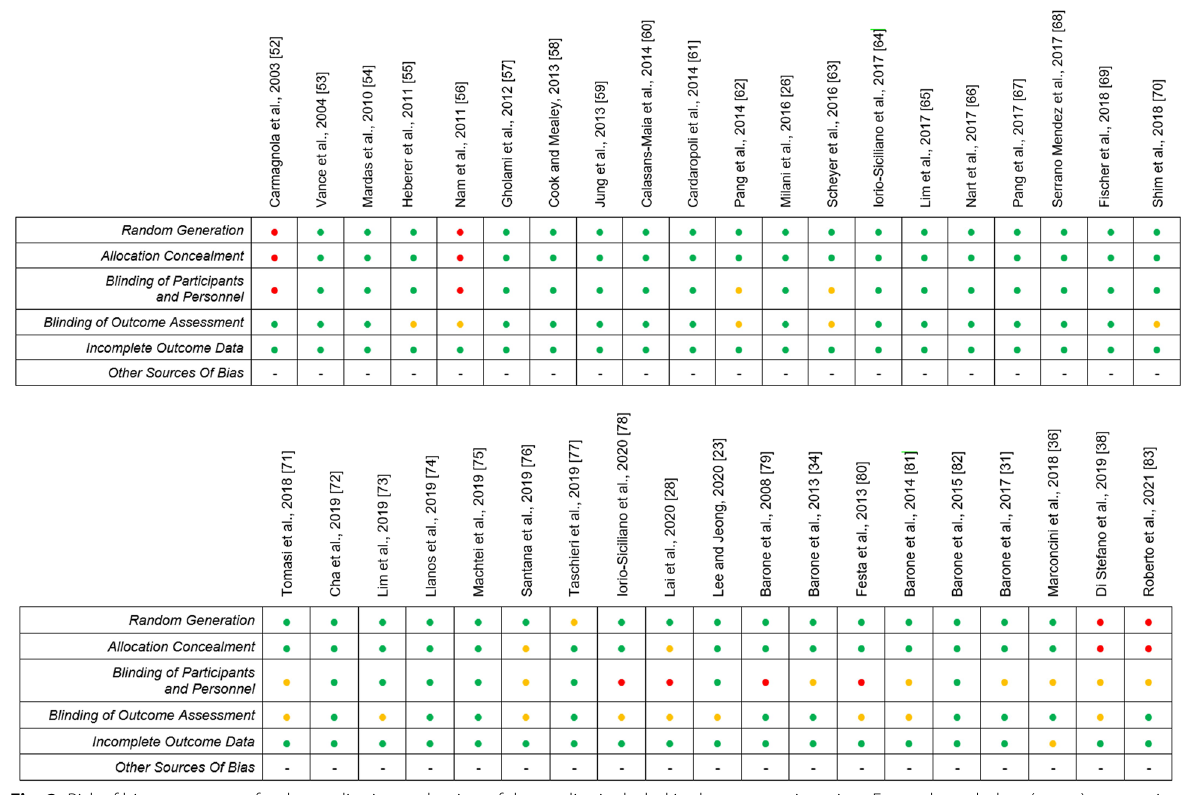
Fig. 2 Risk of bias assessment for the qualitative evaluation of the studies included in the systematic review. For each study, low (green), uncertain (yellow), or high risk (red) of bias was assessed according to the presence of established quality